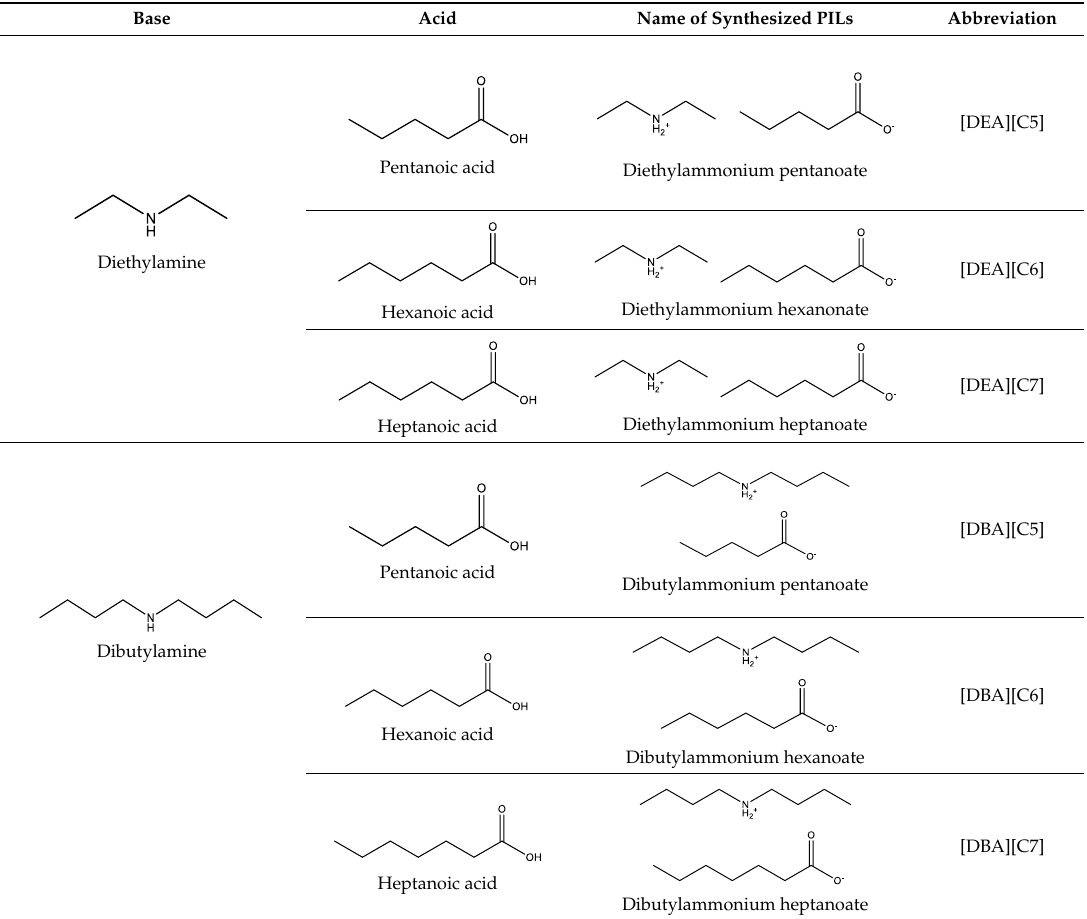
Table 1. List of acids, bases and new ammonium-based protic ionic liquids (PILs) synthesized in this work.